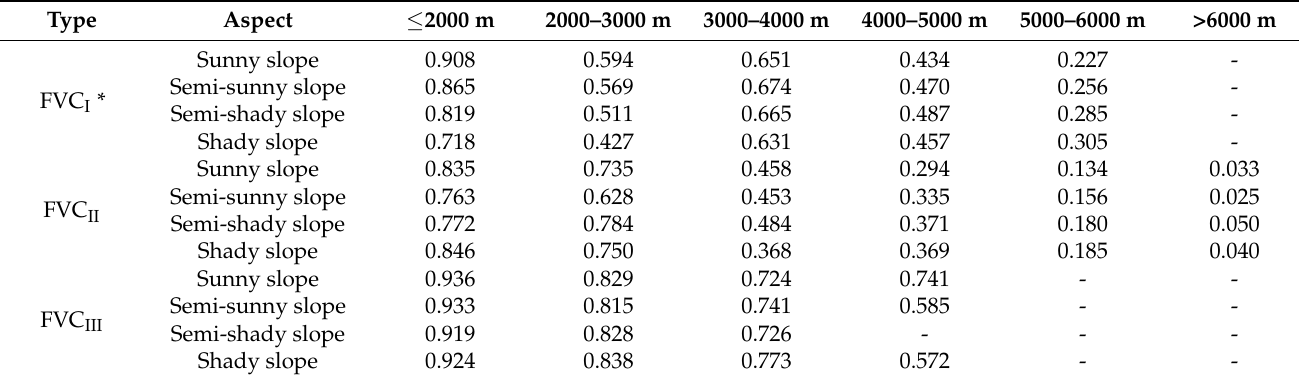
Figure 6. Variation of FVC at different elevation levels for different types of soil on the Qinghai–Tibet Plateau. Table 1. Variation of FVC with different elevation and aspect.